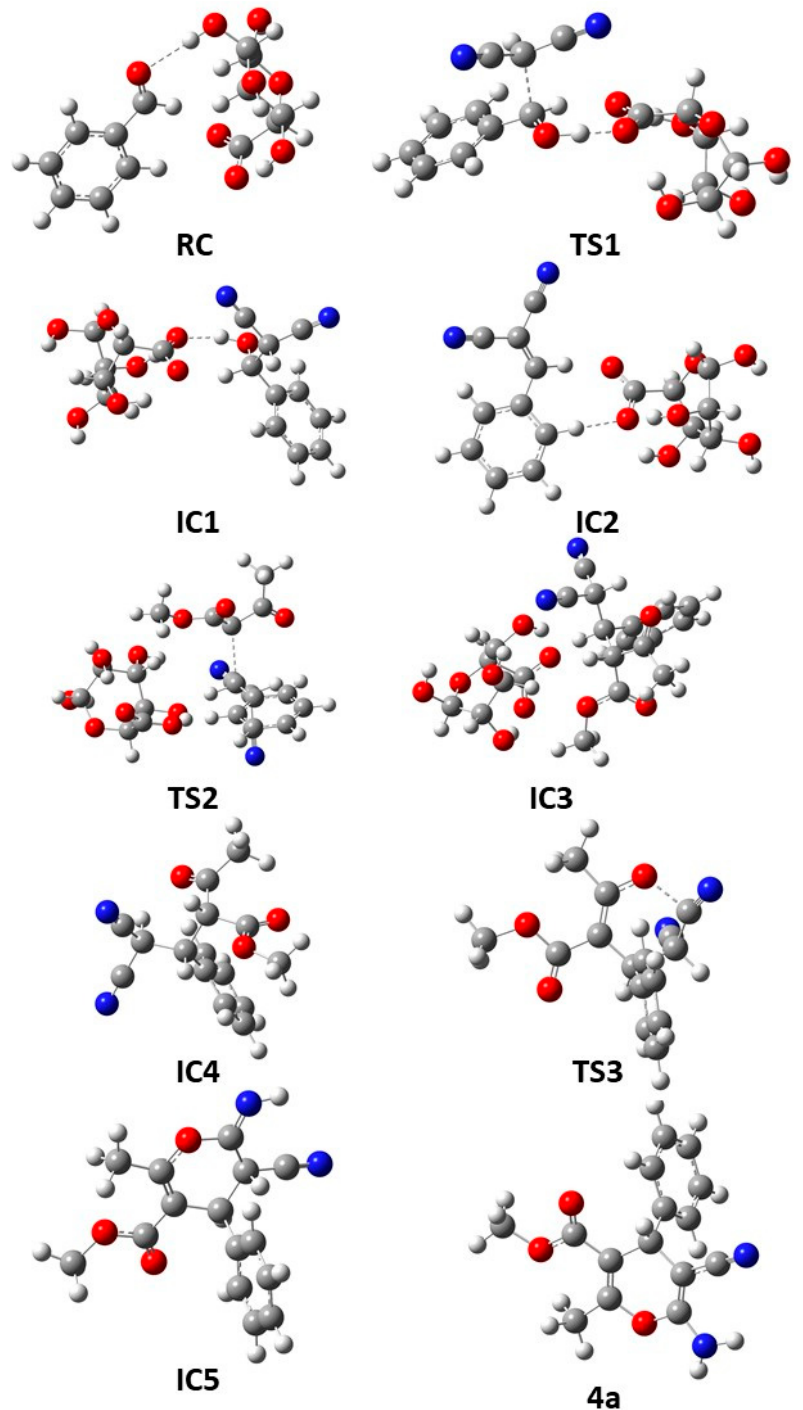
Figure 6. Optimized structures of all intermediates for the synthesis of 4a catalyzed by SA. For color codes: grey (carbon atoms), red (oxygen atoms), blue (nitrogen atoms) and white (hydrogen atoms).